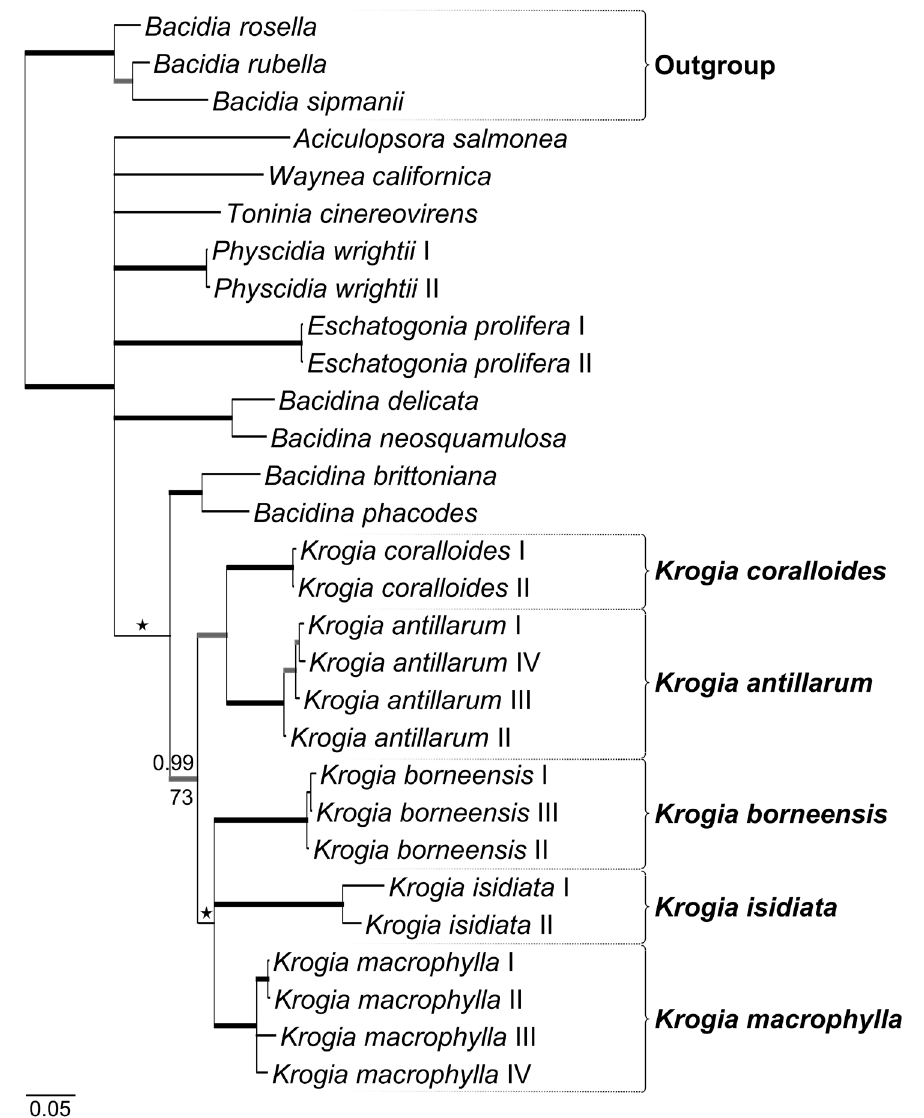
Figure 1. Hypothesis of the phylogenetic relationships and placement of the 15 Krogia accessions. It shows the extended majority-rule consensus tree resulting from the Bayesian MCMC analysis with Bayes- ian PP ≥ 0.7 (above branch) and/or Garli maximum likelihood BS ≥ 50 (below branch) and branch lengths. Strongly supported branches (PP ≥ 0.95 and BS ≥ 95) are marked in bold; branches with PP ≥ 0.95 and BS ≥ 70 are marked in bold grey; branches only supported by PP ≥ 0.7 are marked with an aster- isk above the branch. Bacidia rosella , B. rubella and B. sipmanii were used as outgroup. Scale bar indicates 0.05 changes per